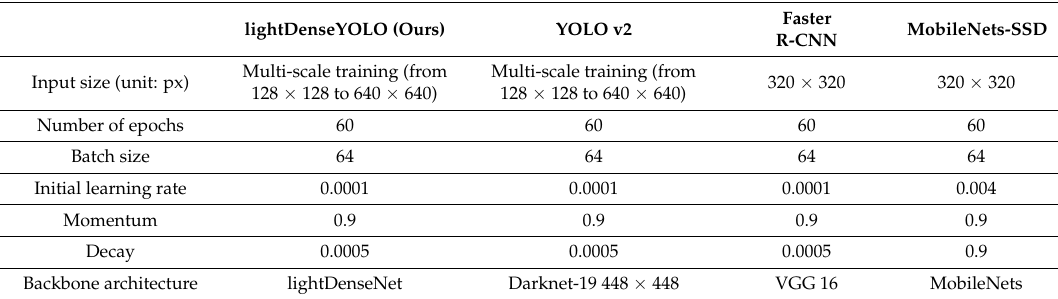
Table 6. Summary of training hyper parameters used on different models for DDroneC-DB2